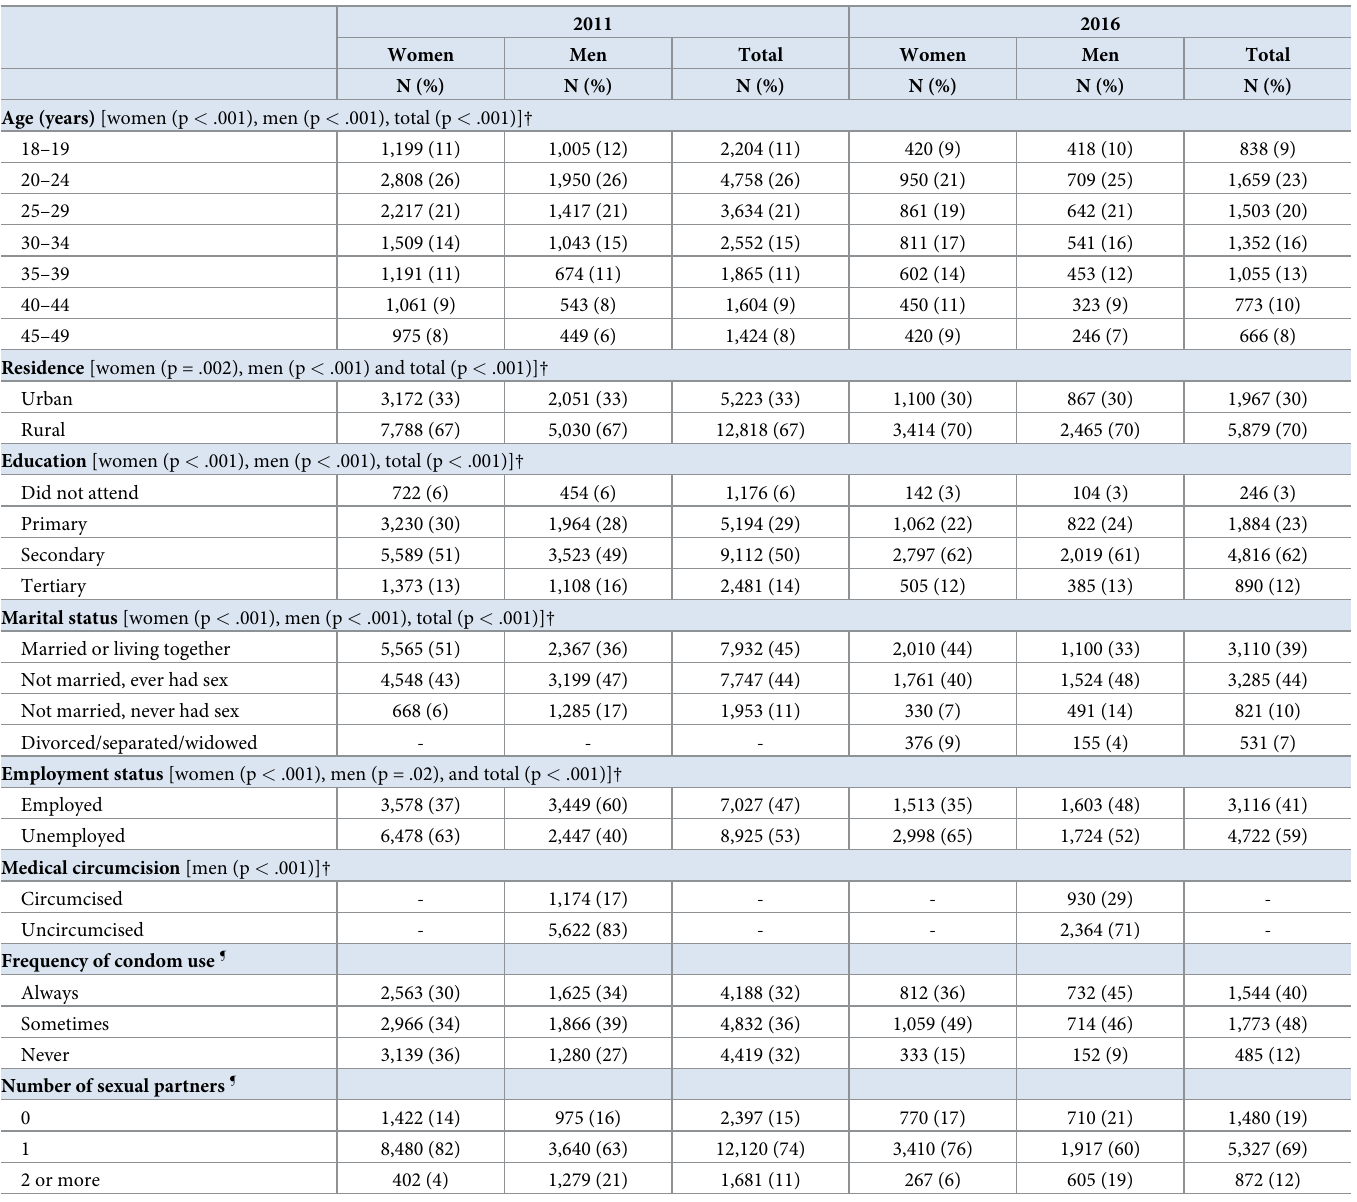
Table 1. Population of adults, ages 18–49 years in Eswatini, 2011 and 2016 �